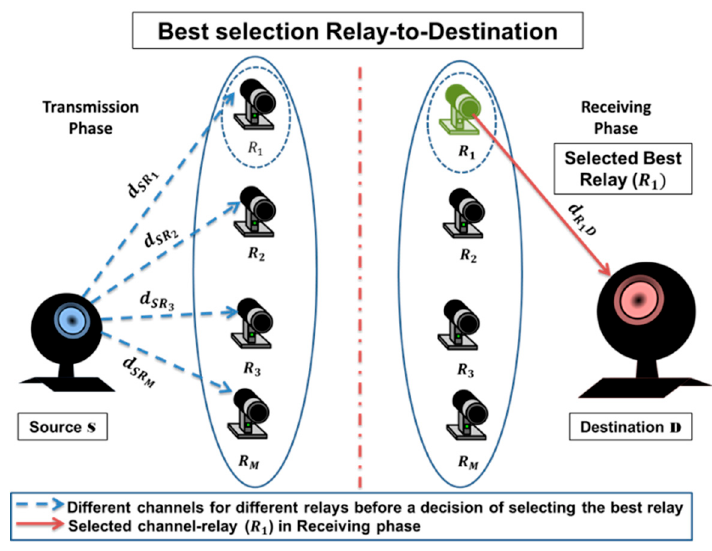
Figure 3. Relay-destination Figure 3. Relay ‐ destination scheme.